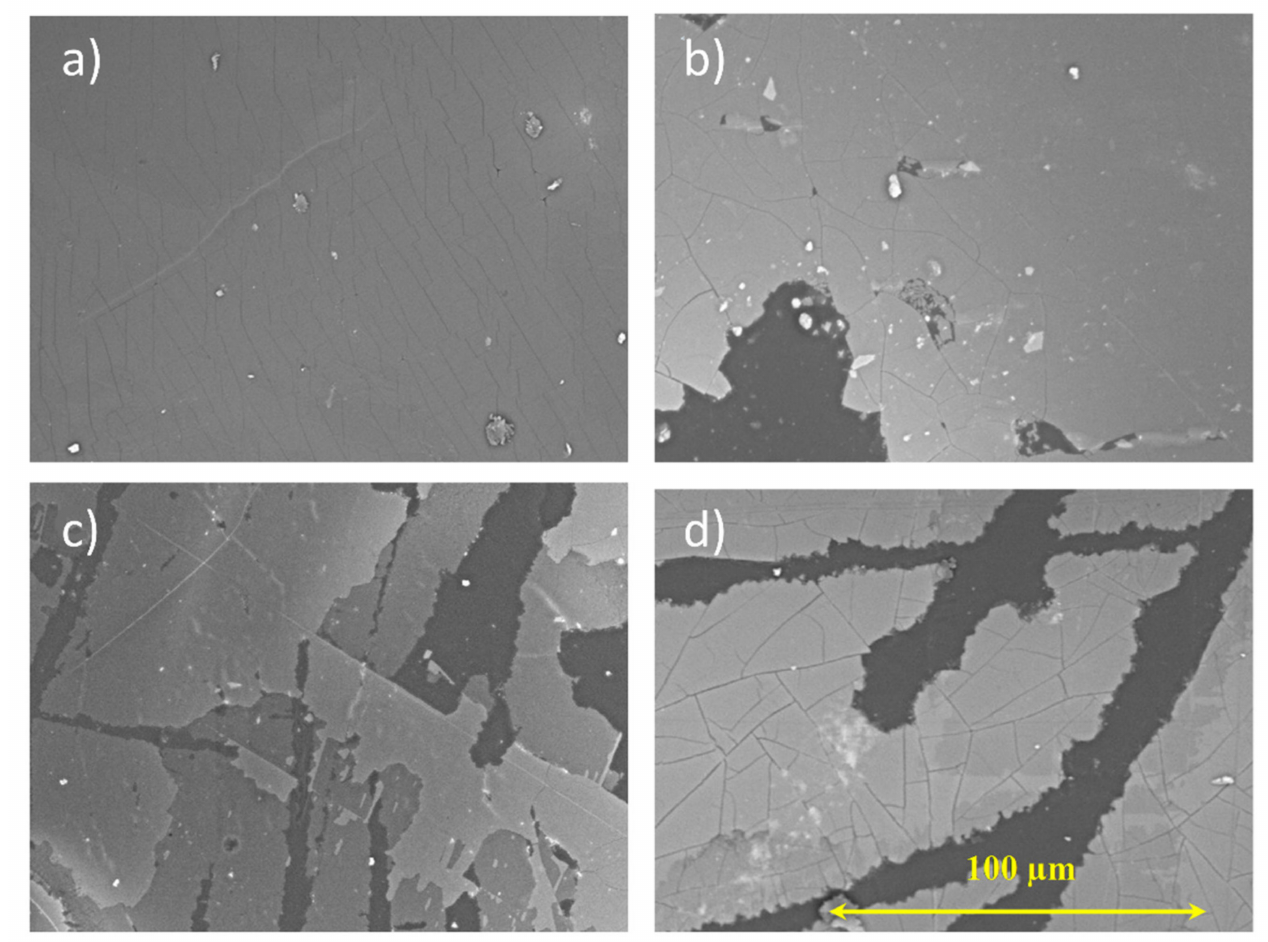
Figure 7. The SEM images for the TiO 2 coatings containing three photocatalyst layers on ( a ) PMMA before and ( b ) after dye degradation with MB, ( c ) MO, and ( d )